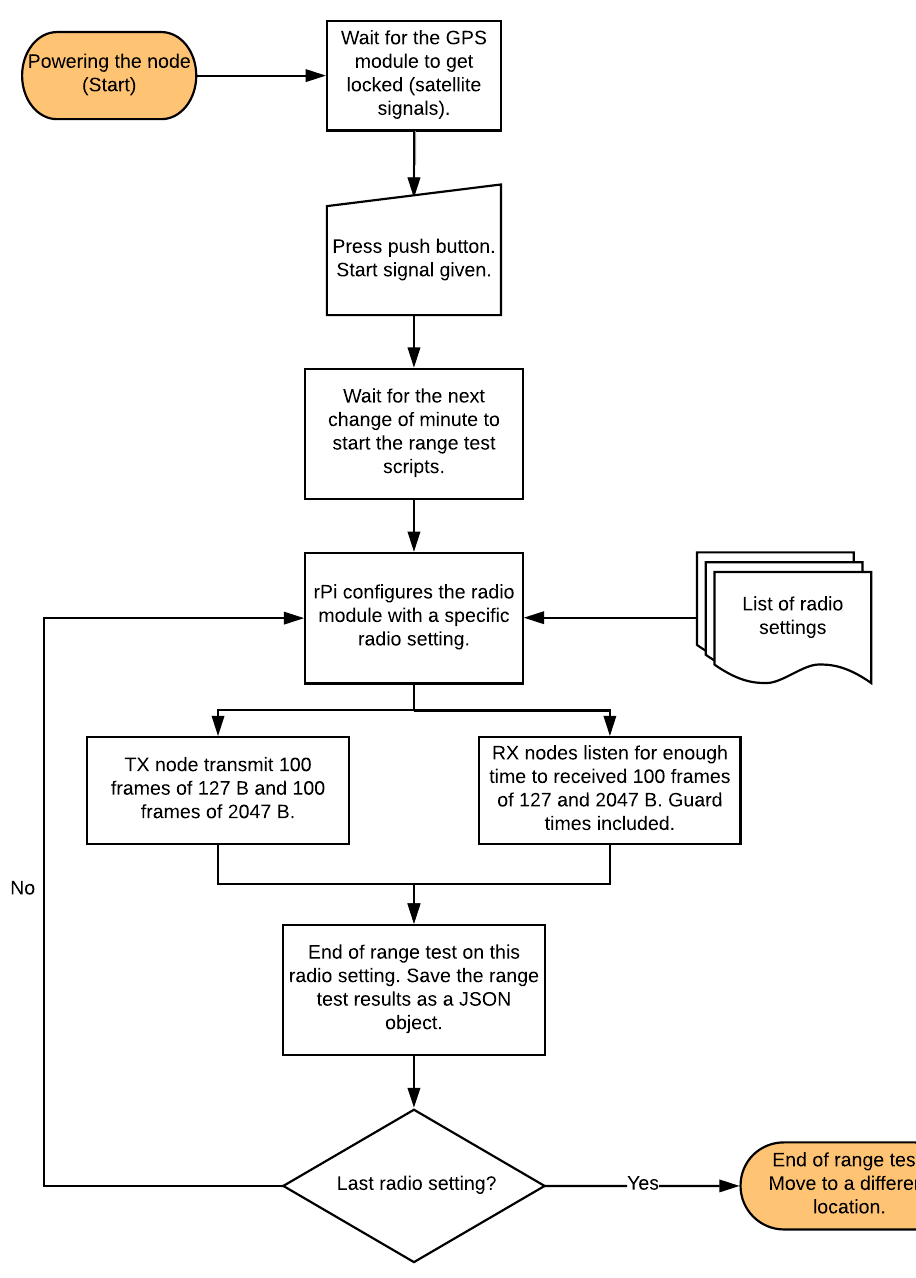
Figure 2. Diagram of the steps followed by each node during an